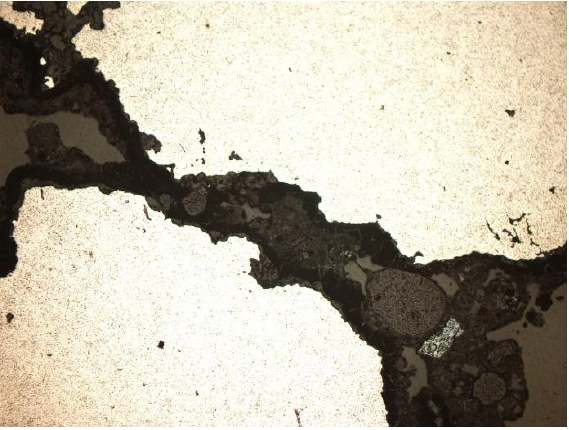
Figure 19. Metallic substance, shiny. SP2 sample, thin section, 1P, 200×, reflected light.